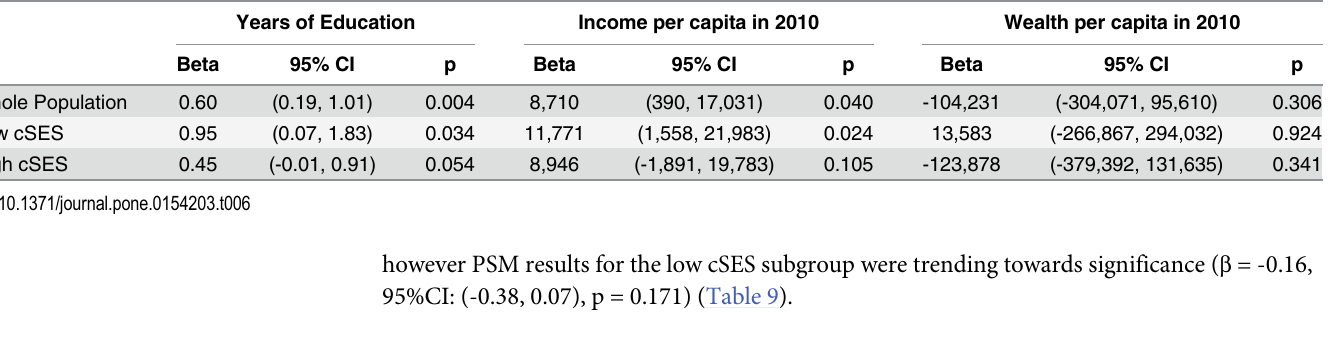
Table 6. Difference in SES markers between veteran wives and non-veteran wives.